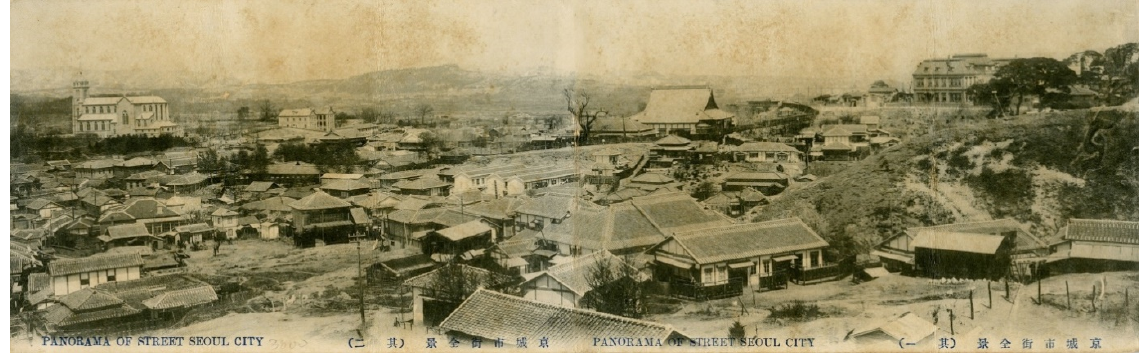
Figure 4. Panorama of Seoul showing the Japanese settlement on Mount Nam. Postcard. Dates unknown. Courtesy of Seoul Museum of History.